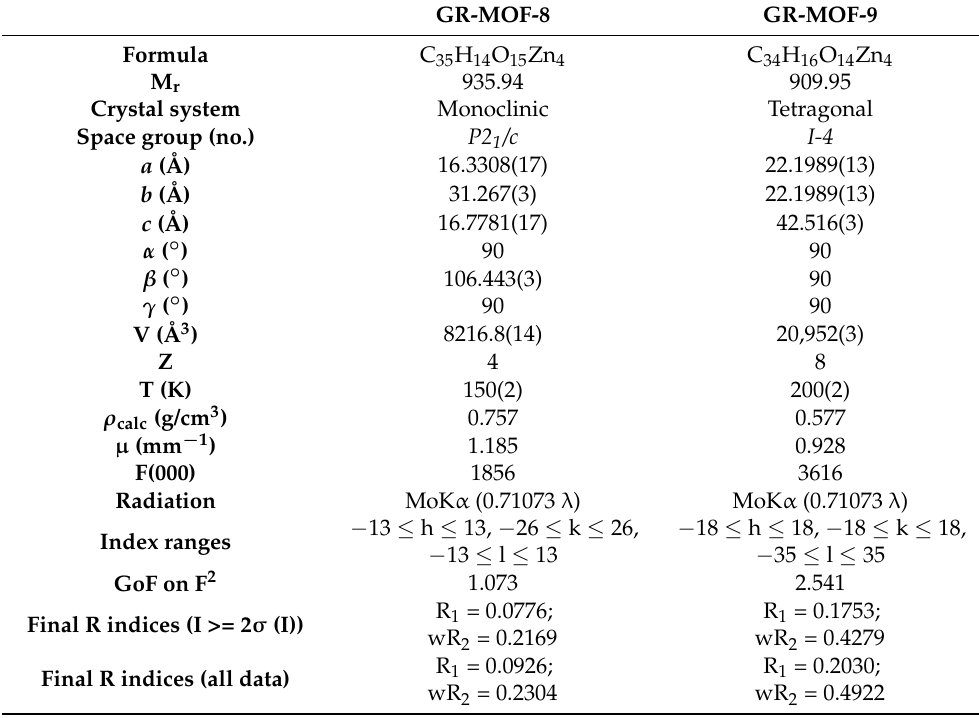
Table 1. Crystallographic data and structure refinement details of compounds GR-MOF-8 and